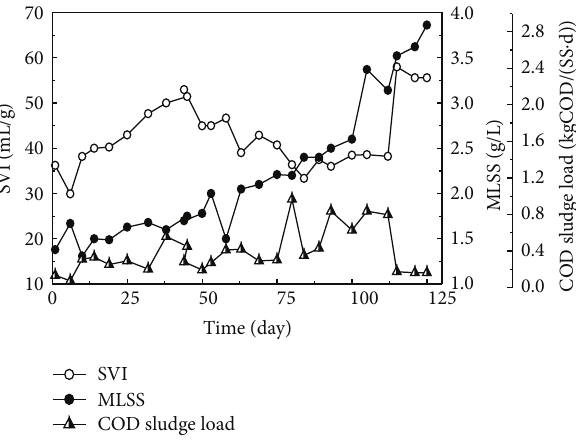
Figure 4: Sludge concentration, SVI, and COD sludge load in the DSTR.